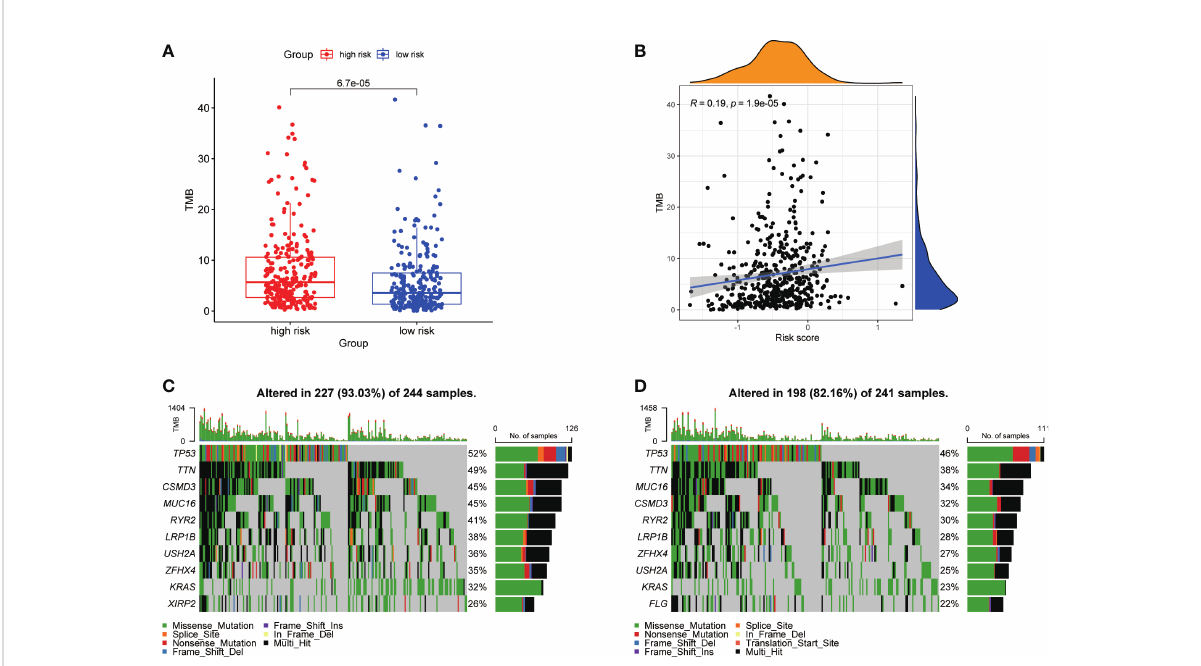
FIGURE 5 Characteristics of tumor mutation burden in TCGA cohort. (A) Differences of TMB between high- and low-risk groups. (B) Correlation analysis of risk score and TMB. (C) Top 10 genes with mutation frequency in high-risk group. (D) Top 10 genes with mutation frequency in low-risk group.